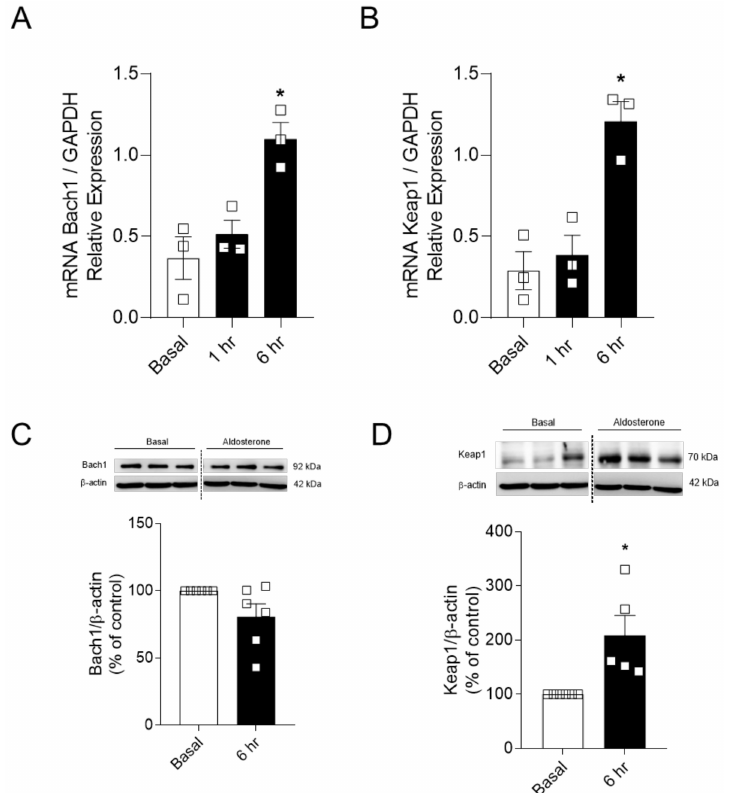
Figure 5. Aldosterone-induced reduced Nrf2 activity is linked to Keap1 upregulation. Gene and pro- tein expression of Bach1 ( A , C ) and Keap1 ( B , D ). The vertical dotted line between the groups indicates that the image obtained from the same membrane was cropped. Data represent the mean ± SEM. One-way ANOVA: * p < 0.05 vs. basal. n = 3–6 for each experimental